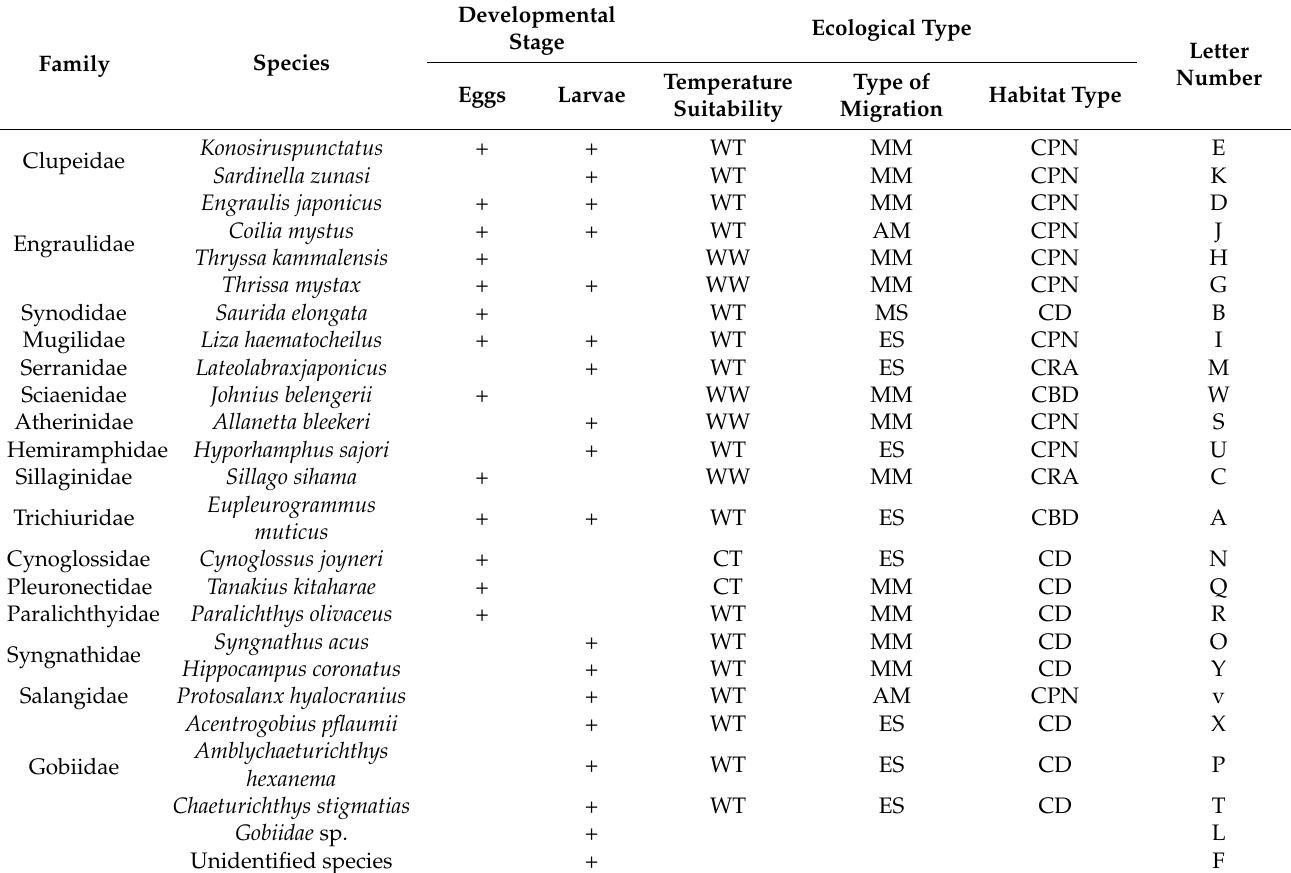
Table 2. Species of fish eggs and larvae in the Yellow River estuary.